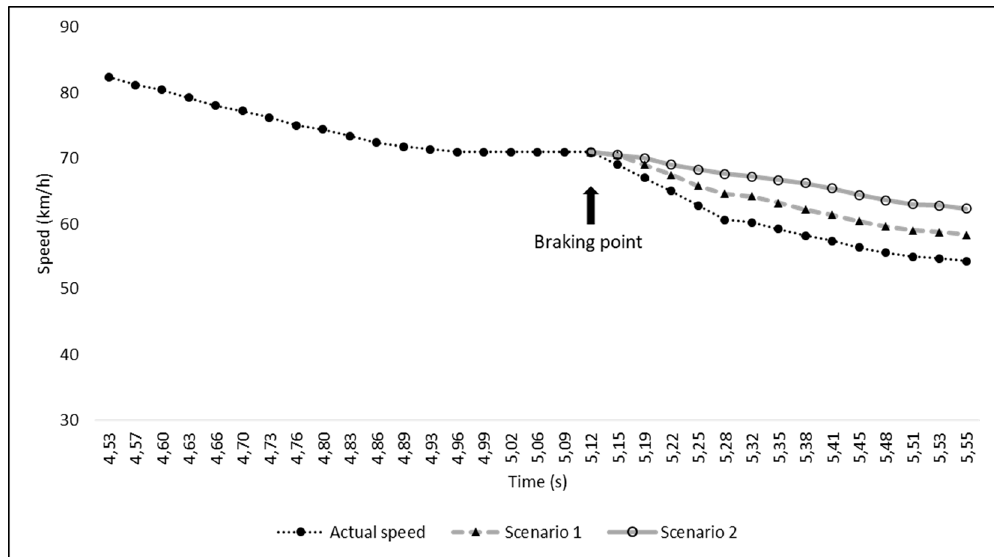
Figure 9. Rossi’s actual speed (moving an average of 5 points), 33 frames before the point where he narrowly missed colliding with Morbidelli’s careening bike. As described in the legend, the solid dots represent Rossi’s real speed and the solid triangles represent the speed in hypothetical scenario 1, while the empty dots represent the speed in scenario 2.